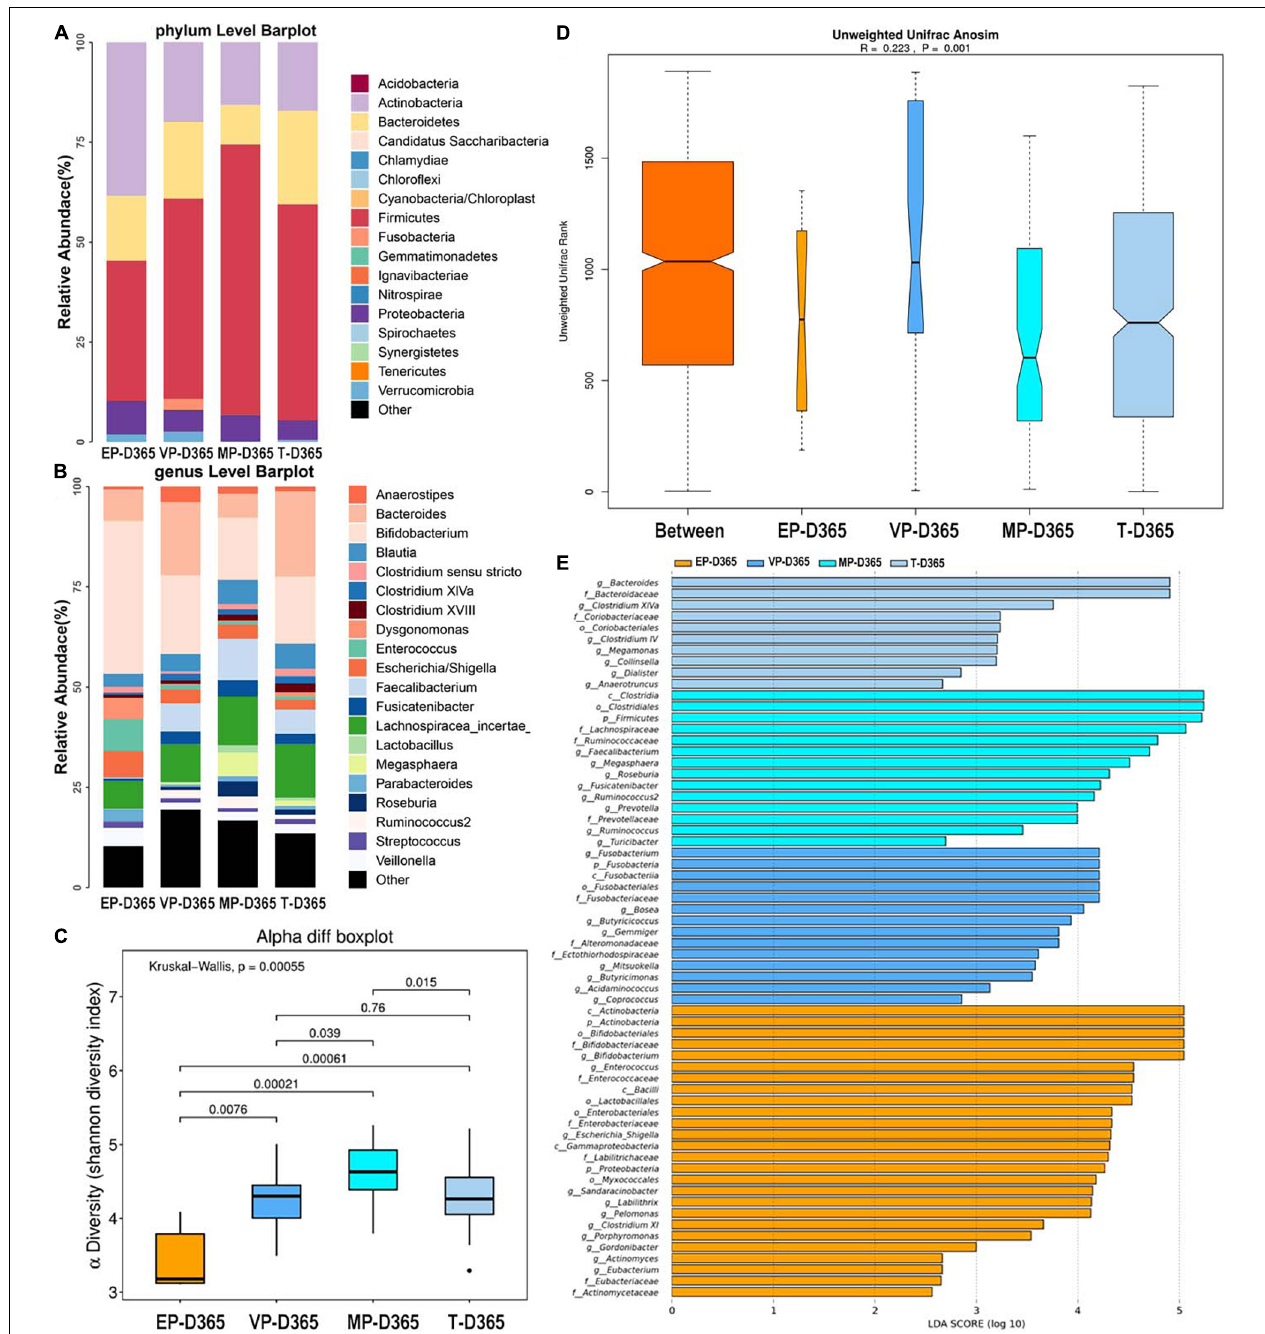
FIGURE 6 | The composition of gut microbiota from neonates with different gestational ages at 365 days after birth. EP, extremely preterm; VP, very preterm; MP, moderate to late preterm; T, full-term. (A) Comparison of abundance at phylum level. (B) Comparison of abundance at genus level. (C) Shannon diversity index of α diversity. (D) Anosim analysis of β diversity. (E) Communities or species that have significantly different effects for infants with different gestational ages at 365 days after